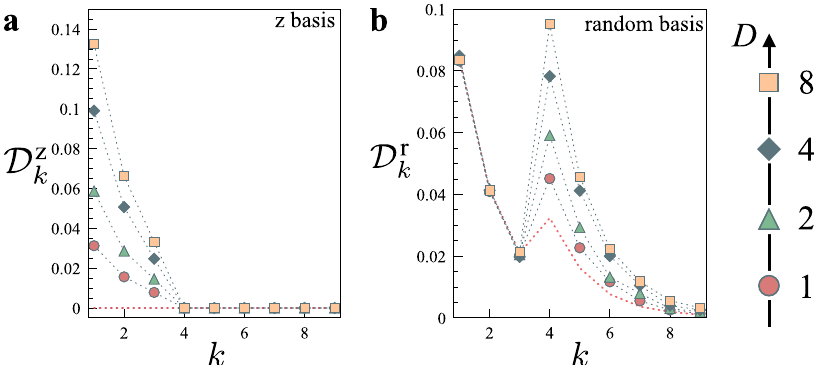
Fig. 3 Dissimilarity results for Dicke states. Partial dissimilarities of Dicke states with different D index calculated in the σ z ( a ) and the random ( b ) bases. The trivial state ( 0 j i (cid:2) 16 ) pro fi les (dashed red lines) are given for comparison.